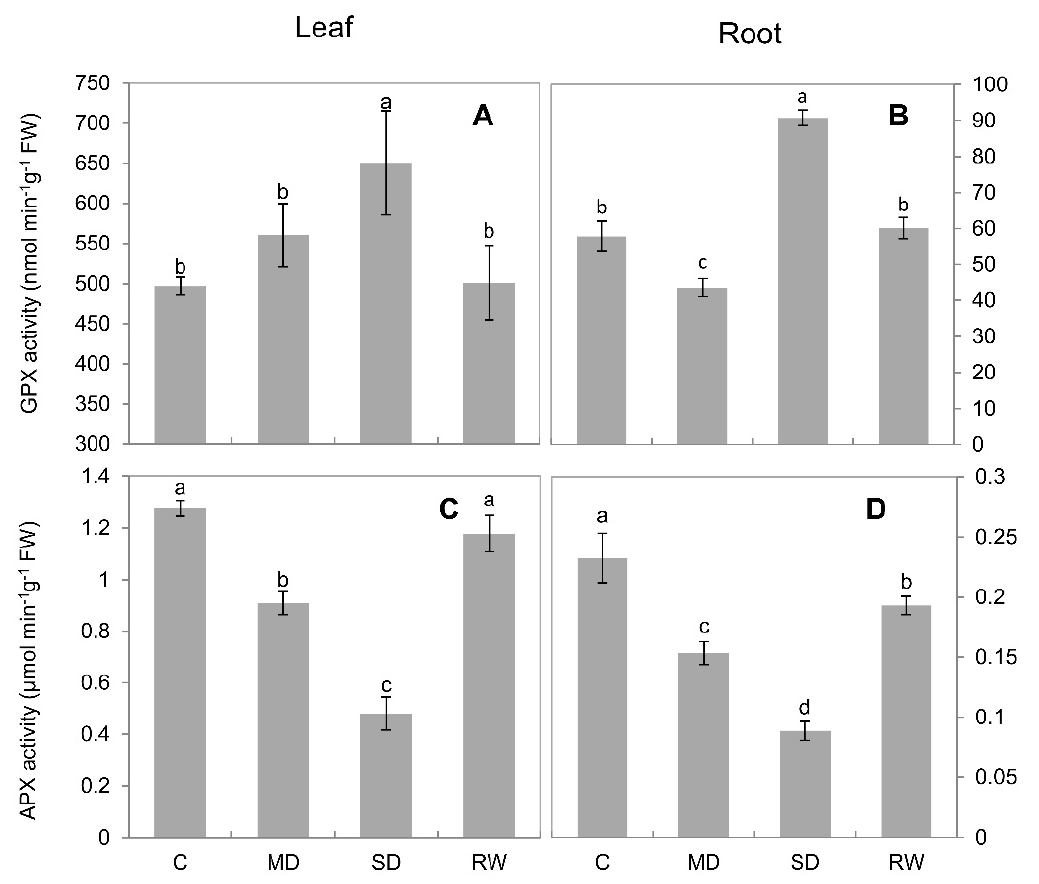
Figure 5. Antioxidant enzyme activity in C. duriuscula in response to drought stress. C-control, MD-mild stress, SD-severe stress, RW-re-watering. ( A , B ) GPX activity. ( C , D ) APX activity. Data are means ± SE ( n = 3–6). Data labeled with different lower-case letters are significantly different at p < 0.05.